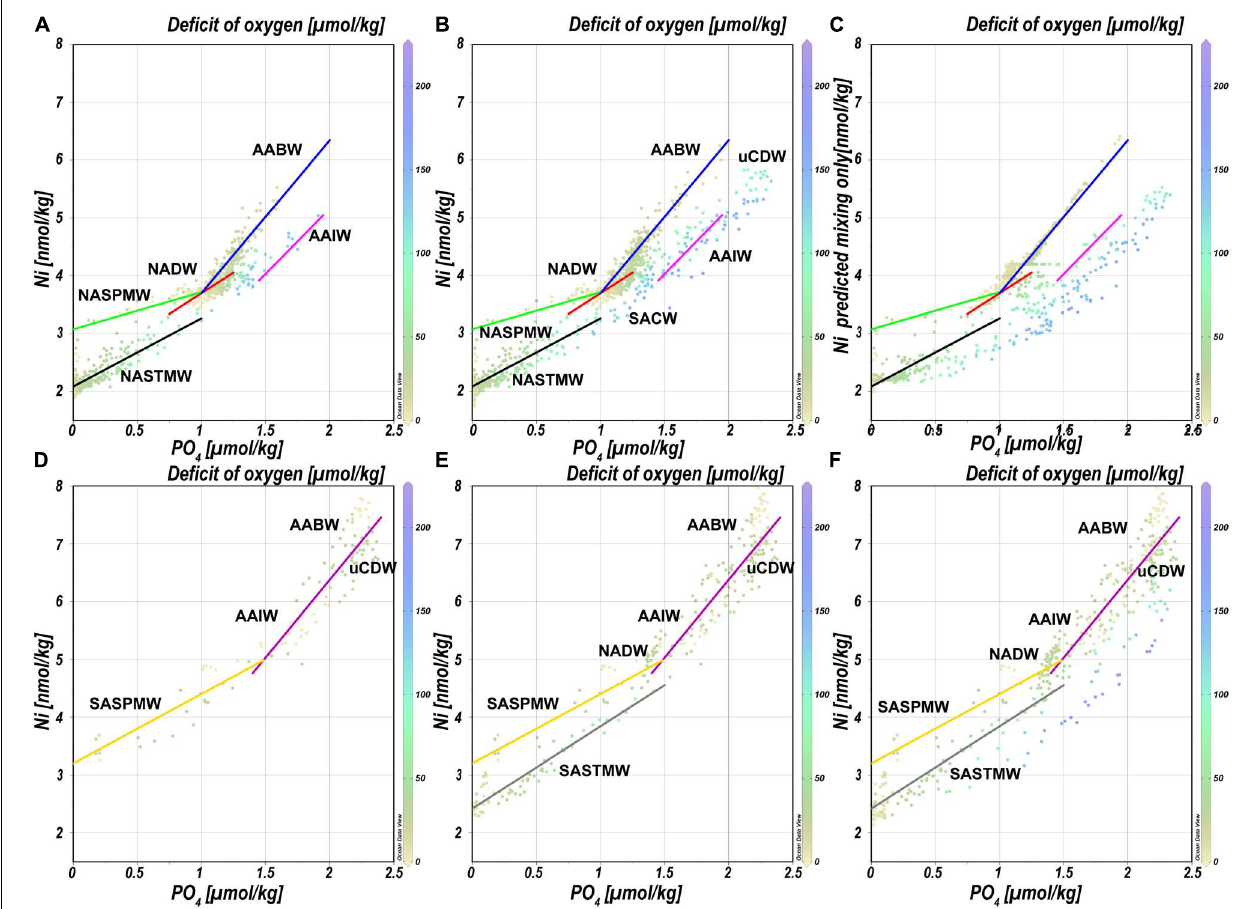
FIGURE 6 | Concentrations of Ni versus concentrations of PO 4 for various parts of the transect as detailed in the text. Equations and other details for the regressions can be found in Table 3 , note that the regressions are based on a subset of the data and not necessarily on all data presented in a plot. Concentrations are measured concentrations of Ni and PO 4 with the exception of (C) where the modeled concentration of Ni versus the measured concentration of PO 4 is presented. (A) Relationships north of 20 ◦ N. (B) Relationships in the NH. (C) Relationship between Ni as predicted by the mixing only model and observed concentrations of PO 4 in the NH. (D) Relationships south of 40 ◦ S. (E) Relationships south of 20 ◦ S. (F) Relationships in the SH. Abbreviations: AABW, Antarctic Bottom Water; AAIW, Antarctic Intermediate Water; NASPMW, North Atlantic Sub-Polar Mode Water; NASTMW, North Atlantic Sub-Tropical Mode Water; NADW,